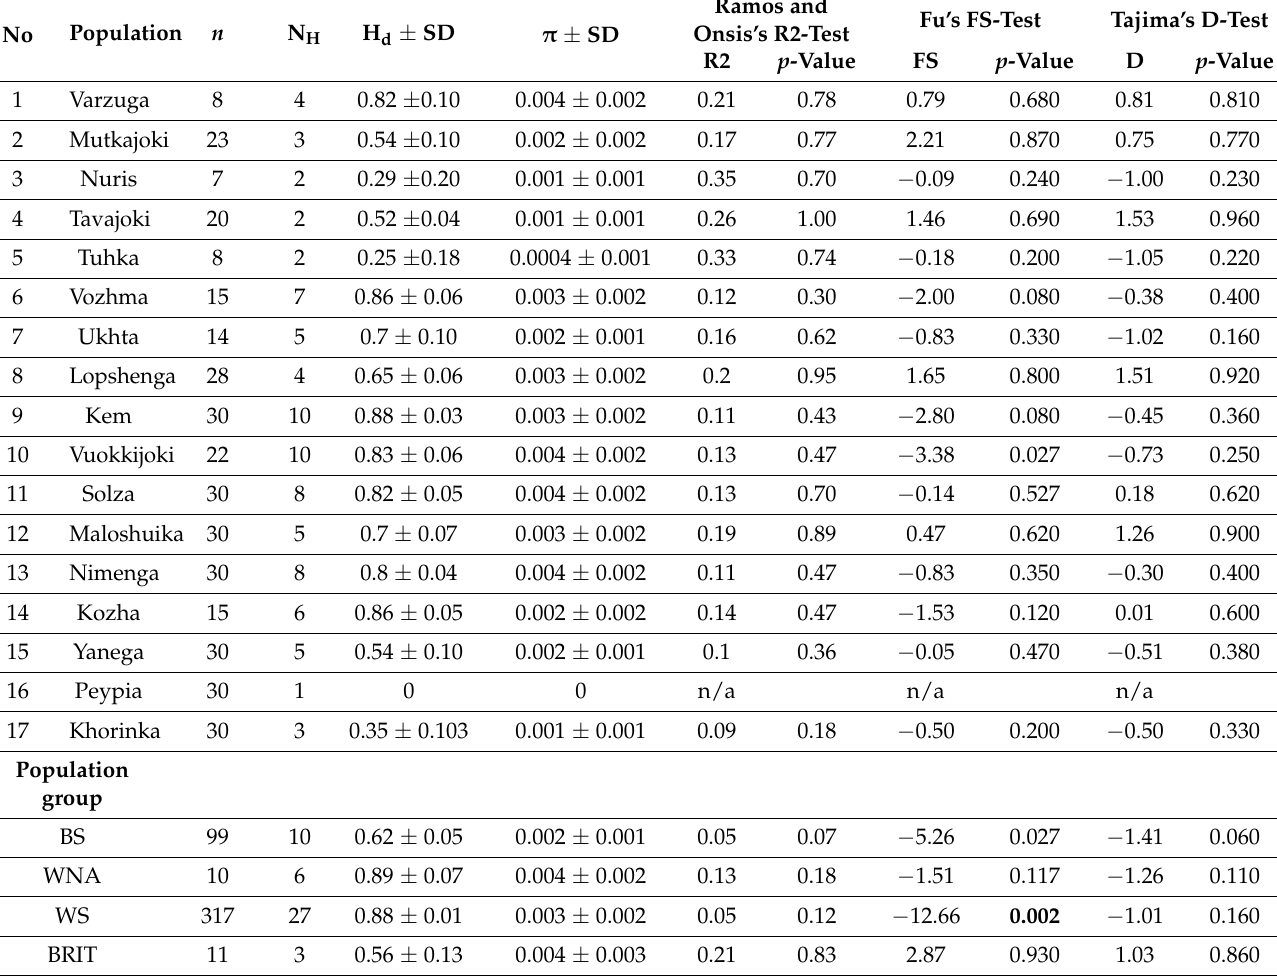
Table 1. Summary of molecular diversity indices estimated from the COI sequencing data of Mar- garitifera margaritifera : sample size ( n ), number of haplotypes (N H ), haplotype diversity (H d ), and nucleotide diversity ( π ) with standard-deviation values; results of deviation from mutational-drift equilibrium by different tests, statistically significant values are in bold ( p < 0.05 for Tajima’s D and R2, and p < 0.02 for Fu’ Fs). Population numbers correspond to the sampling location numbers